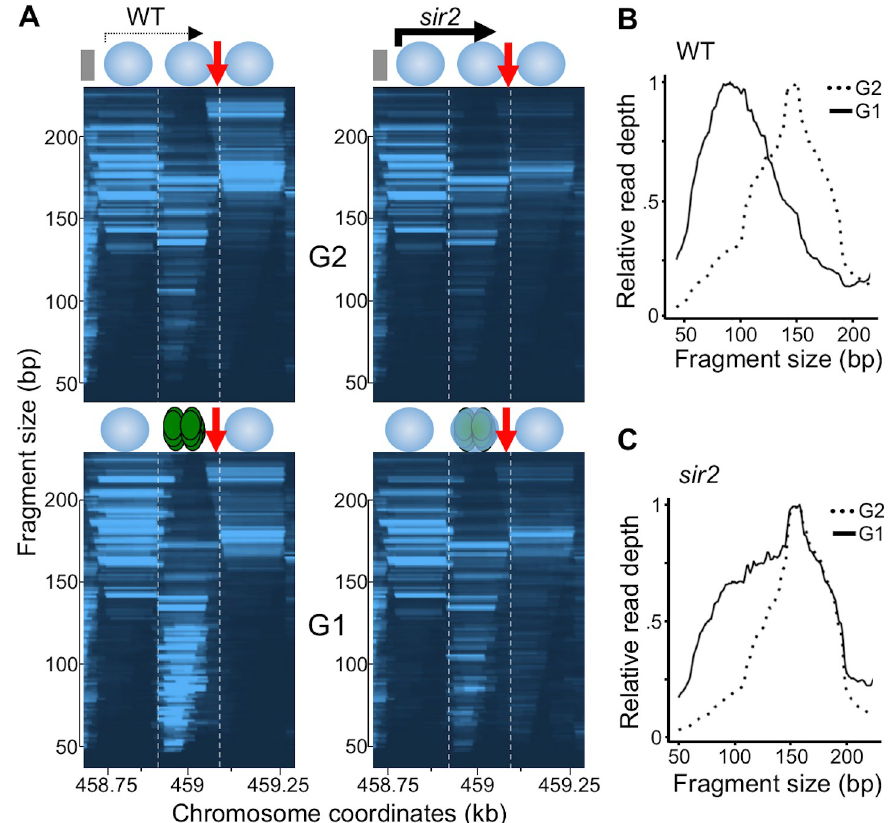
Fig 3. Pre-RC formation is associated with the eviction of the nucleosome at the rDNA origin. A. MNase-seq data from WT (16535) or sir2 (16668) cells arrested in G2 or G1 are shown zoomed in to allow assessment of nucleosome positioning and occupancy. Vertical lines are positioned at the border of the middle nucleosome to facilitate comparison of nucleosome placement. A nucleosome between the vertical lines competes with the pre-RC for occupancy. Positioning of this nucleosome and the two flanking nucleosomes does not change between G1 and G2. Relative read depth in the genomic region between the two vertical lines in 3A on the Y axis, is plotted according the fragment size (X-axis) in WT (B.) and sir2 mutant (C.). The large fragment sizes, that peak at approximately 160 bp correspond to nucleosome, whereas smaller fragments correspond to the pre-RC. In WT cells the nucleosome size fragments are depleted in G1 compared to G2, whereas they persist in sir2